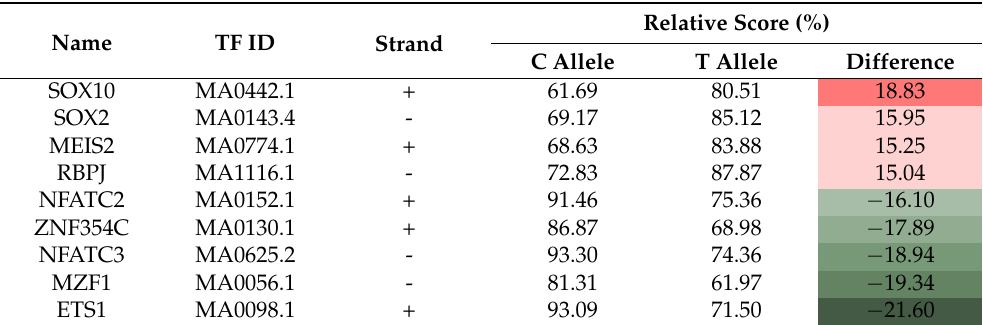
Table 3. List of transcription factors that were affected by rs3811792 polymorphism. Positive values of relative score differences on a red background indicate that the minor allele increased the TF binding probability, negative values on a green background indicate that the minor allele decreased the TF binding probability. A darker shade indicates that there is a larger difference.